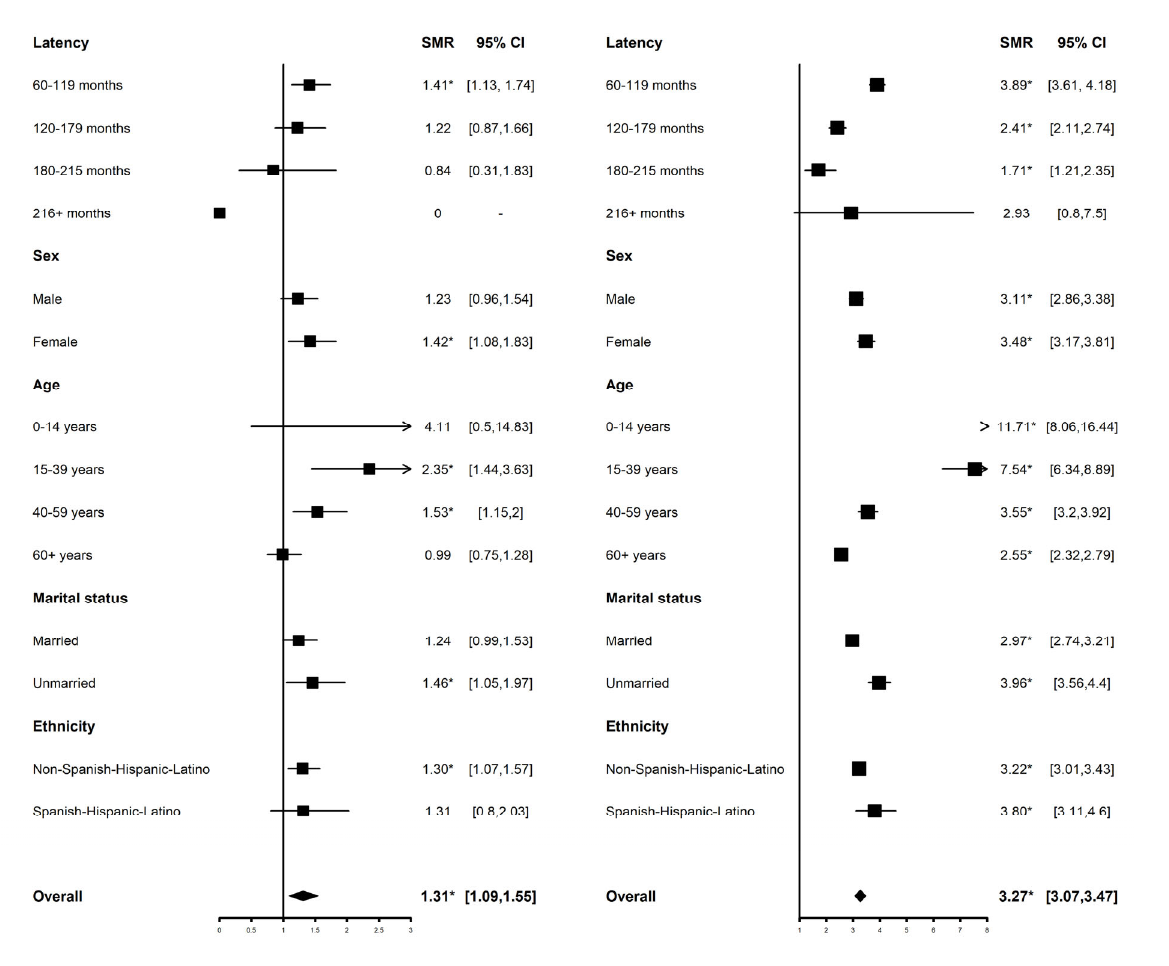
Figure 1. The SMRs of all-cause deaths among >5-year survivors of APL ( A ) and non-APL AML ( B ) compared with the general population stratified by demographics and clinical characteristics. The solid vertical lines represent the SMR of 1.0. The horizontal lines represent 95% confidence intervals for the SMRs. The box represents the result of SMR. The diamond at the bottom shows the summary SMR of all the combined individual studies. We used the Poisson exact method for SMR to compute the 95% CI and corresponding p values, and the 95% CIs not including 1 with p < 0.05 were defined as significant differences for SMR. * p < 0.05.